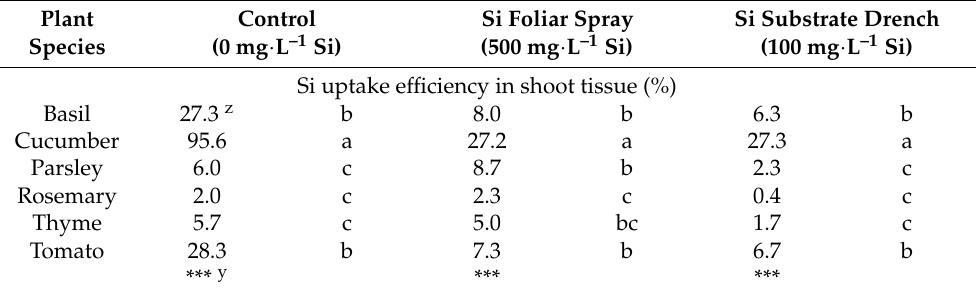
Table 5. Supplemental silicon (Si) treatment effects on percent Si uptake efficiency in shoot tissues for six container-grown edible species. Silicon foliar spray and substrate drench treatments were applied every 7 days during